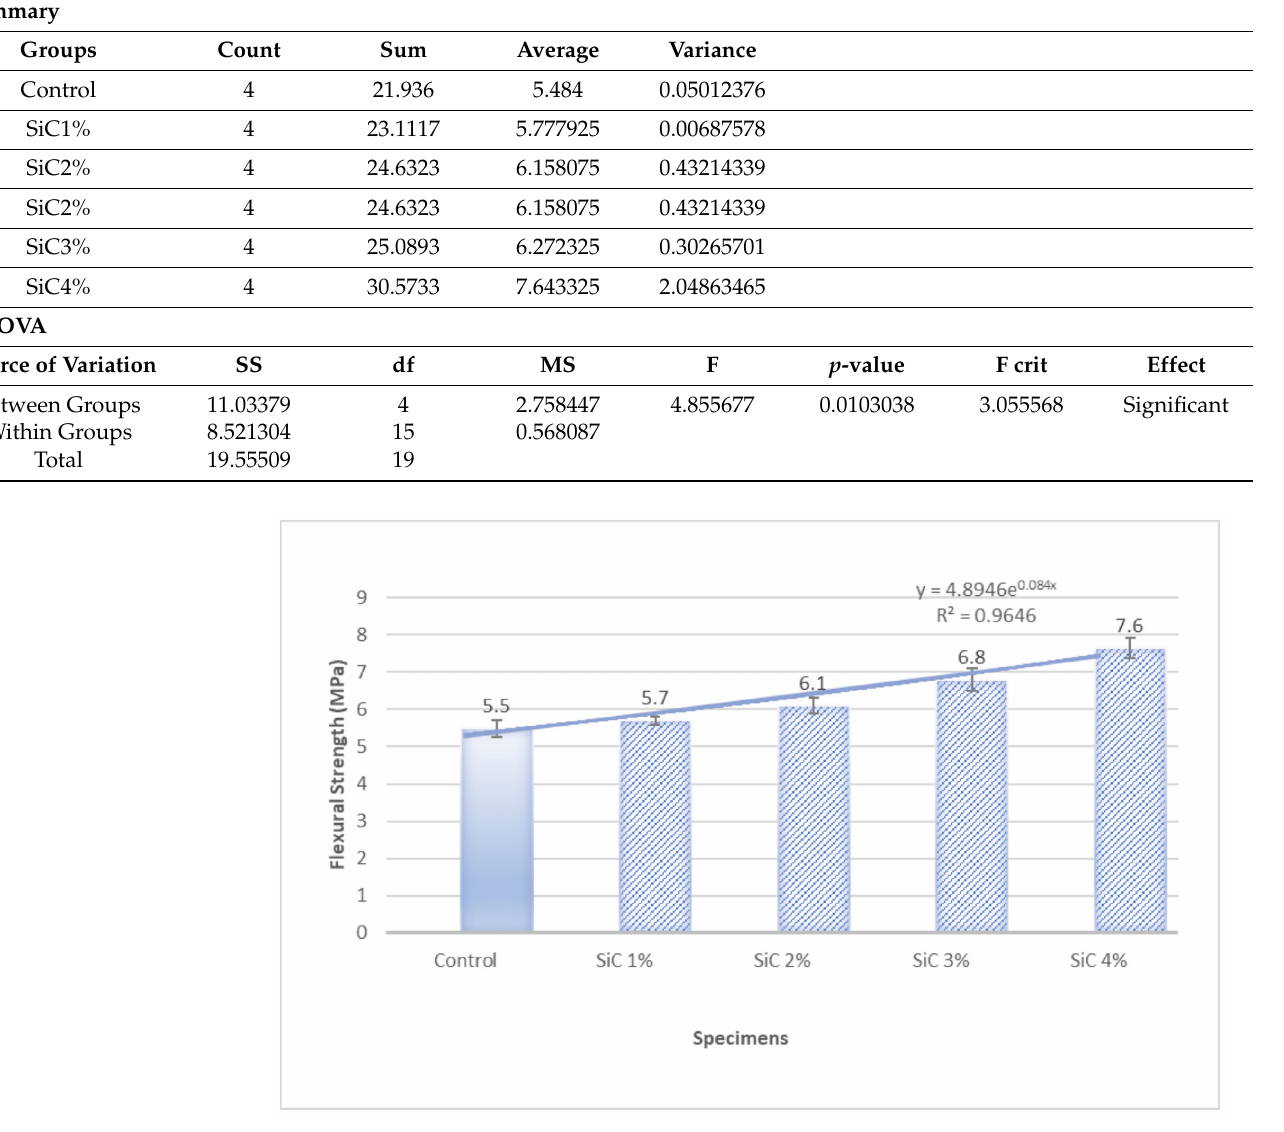
Figure 8. Flexural Strength Variation with the increase in SiC